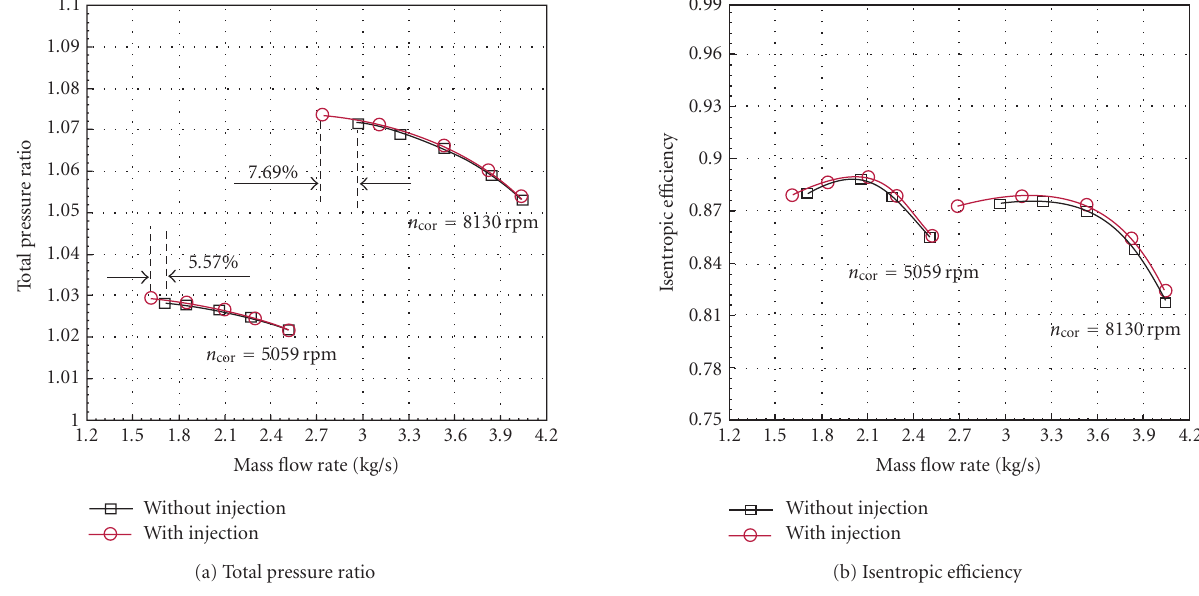
Figure 6: Comparison of measured rotor performance at two di ff erent speeds with and without steady micro-air